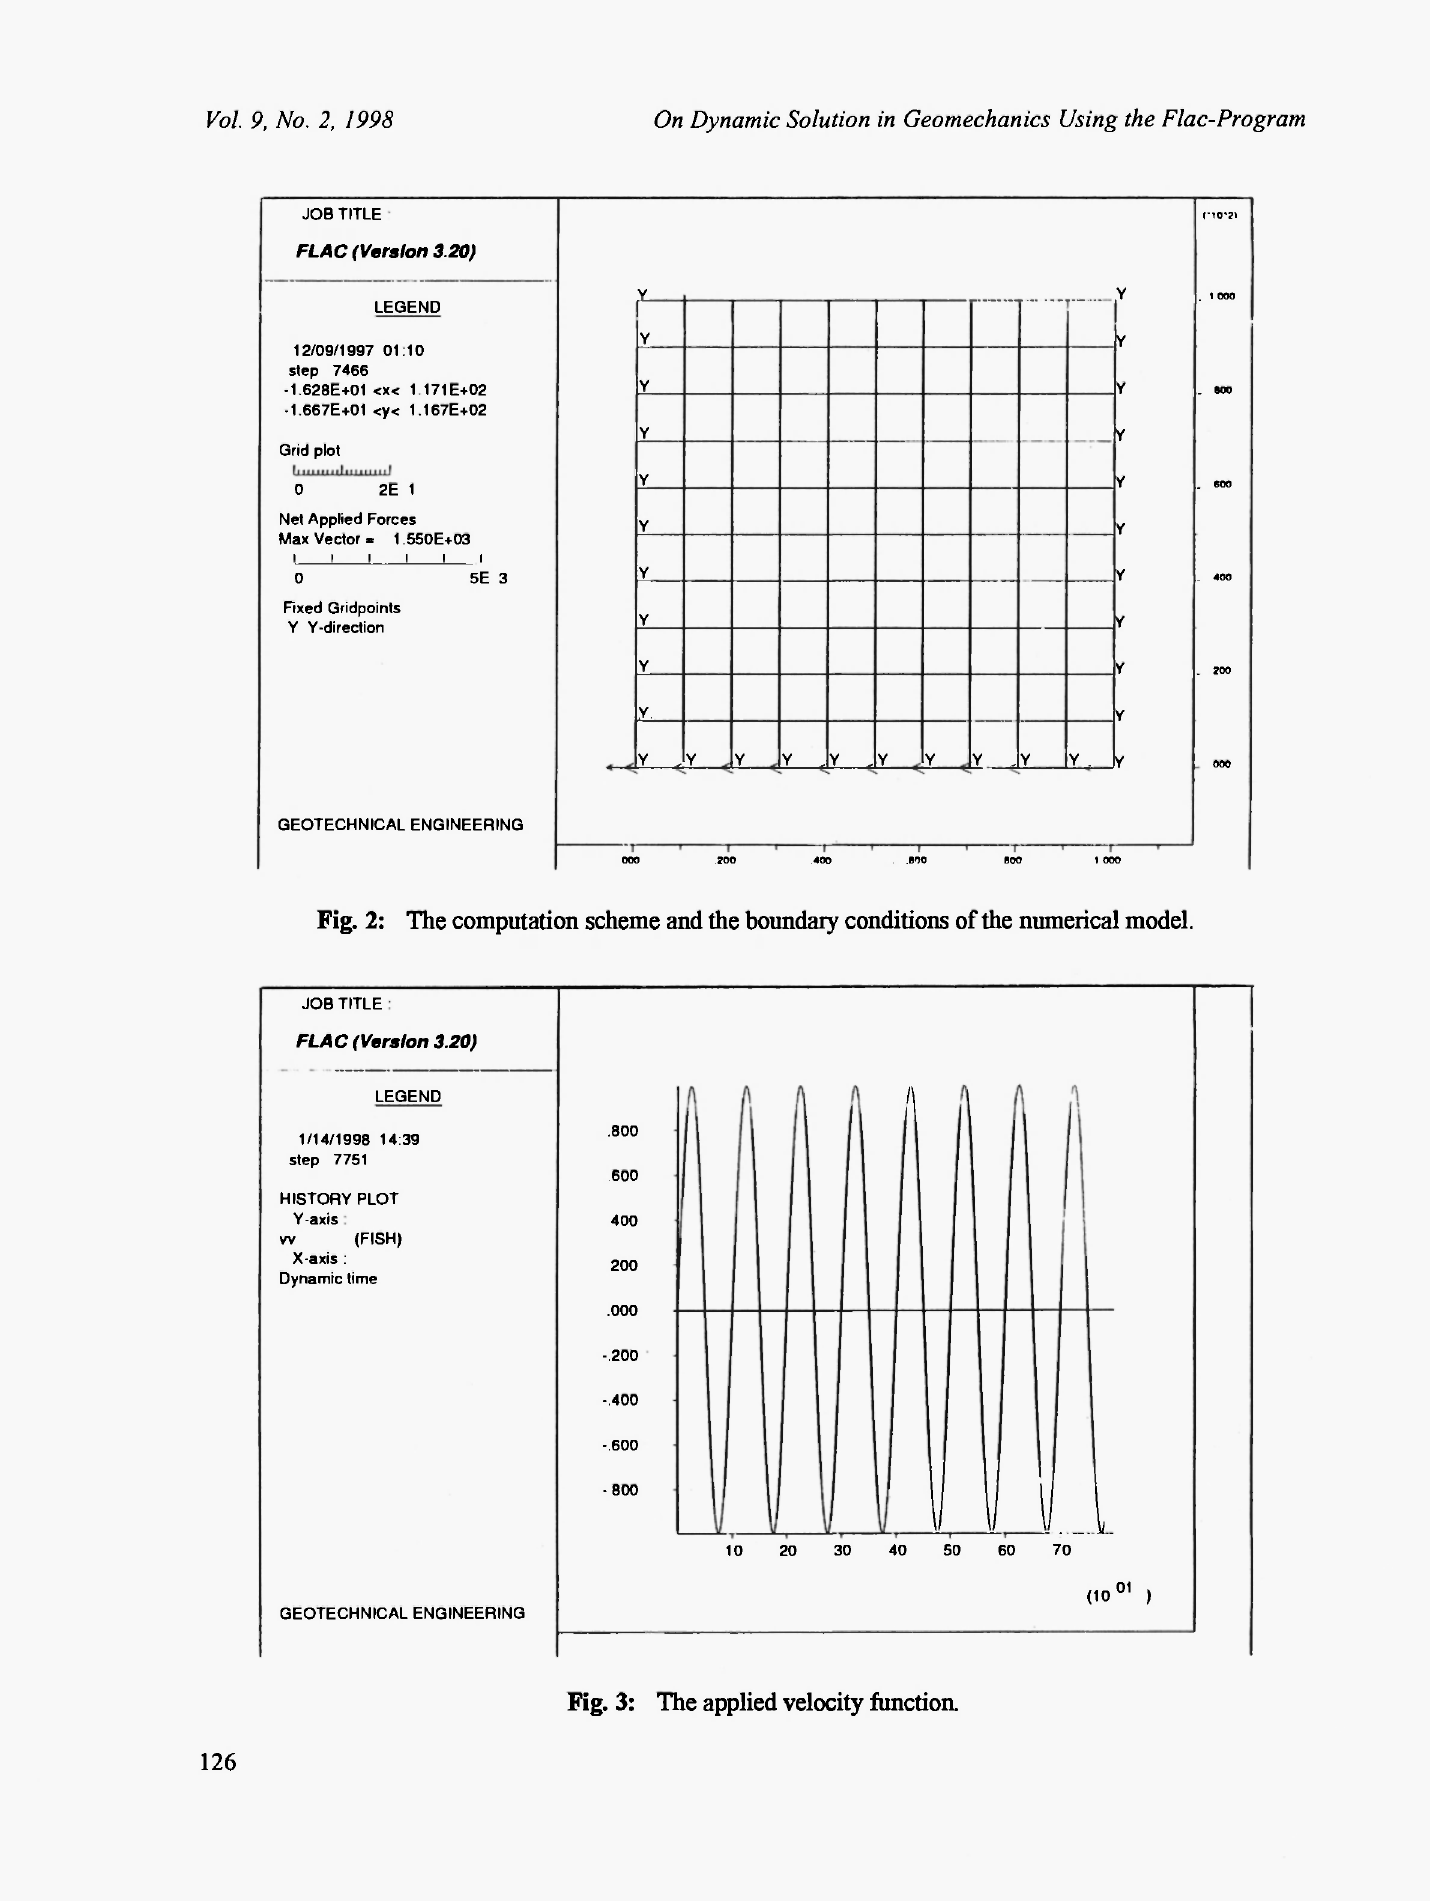
Fig. 3: The applied velocity